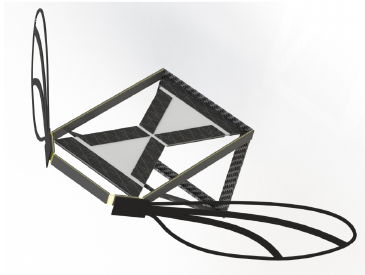
Figure 5. Concept design of a micro aerial vehicle, composed of MEMS and 3D-printed parts. Reproduced with permission from